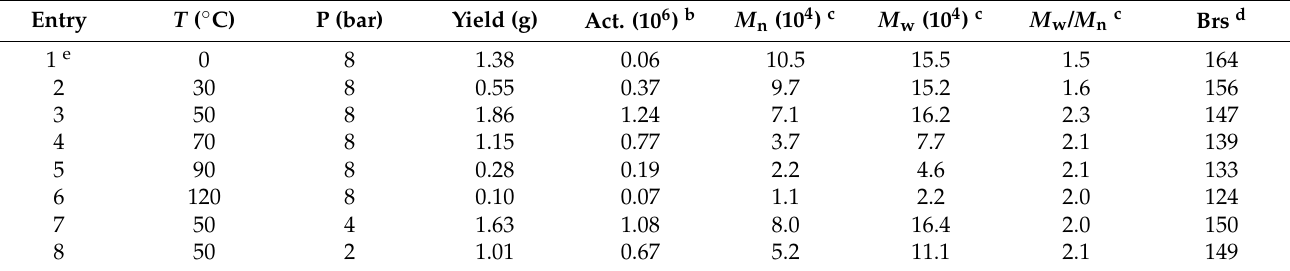
Figure 5. ( a ) Stress–strain curves for selected (co)polymer samples generated by Ipty/ i Pr-Ni . ( b ) Plots of hysteresis experiments of ten cycles at a strain of 300% for the copolymer sample generated by Ipty/ i Pr-Ni . Table 4. Ethylene polymerization catalysed by Ipty/ i Pr-Pd a